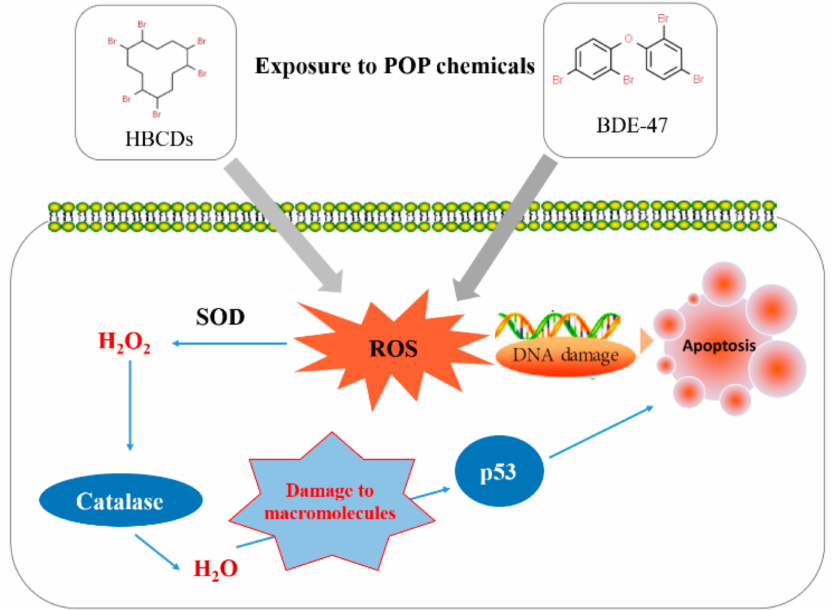
Figure 5. Schematic summary of the suggested molecular process involving antioxidation and p53 - mediated apoptosis in M. japonicus animals exposed to POPs (HBCD and BDE-47). SOD: Superoxide dismutase, ROS: Reactive oxygen